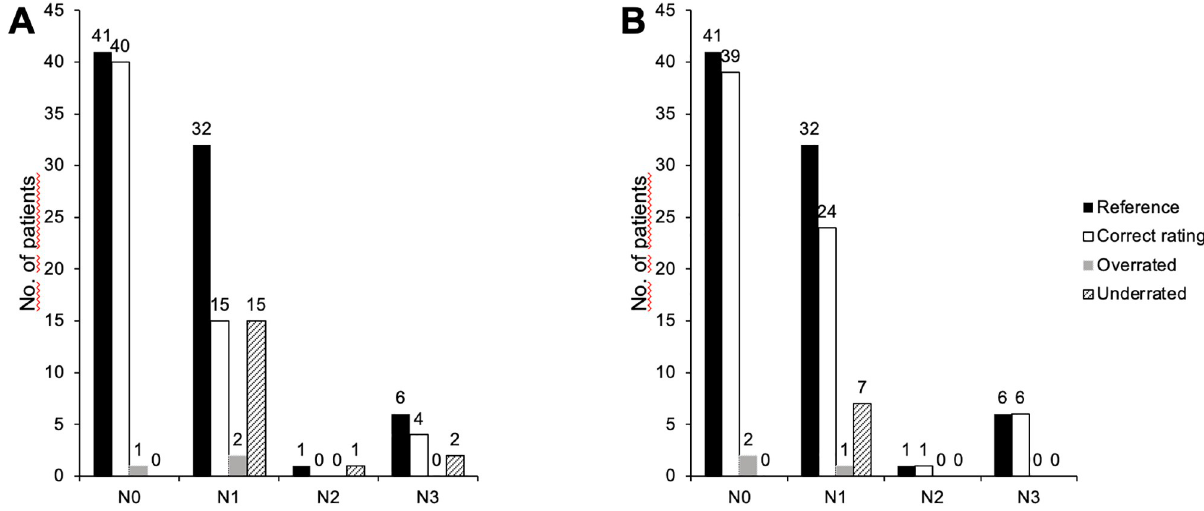
Fig 1. Determination of the lymph node stage in CT (A) and 18 F-FDG PET/MRI (B).